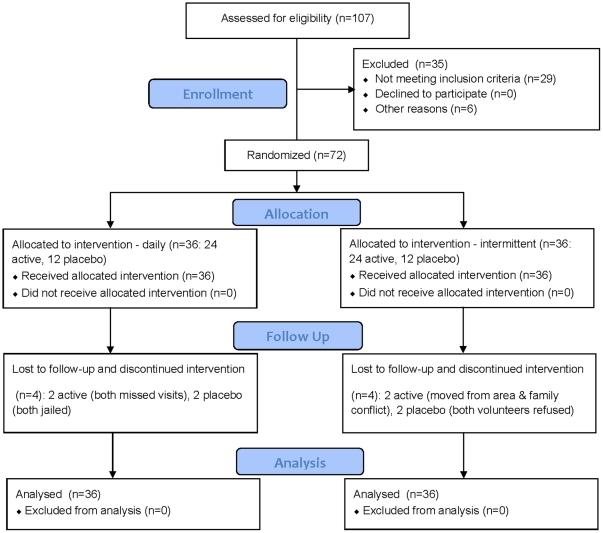
Flow of participants.